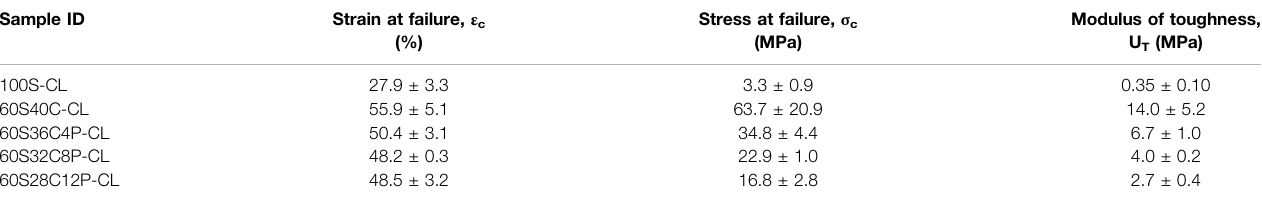
TABLE 3 | Mechanical properties of hybrid monoliths calculated from uni-axial compression test to failure. Mean values ± standard deviation (n ≥ 3). Sample